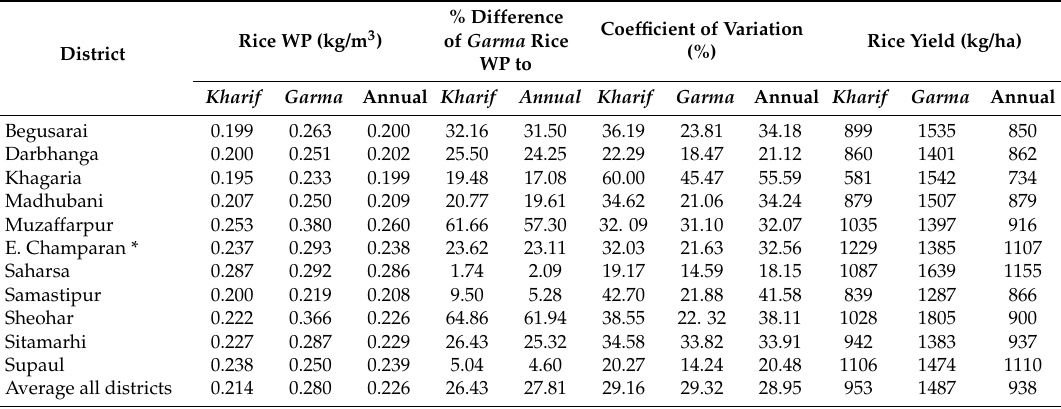
Table 1. Rice water productivity in individual Bihar districts (average